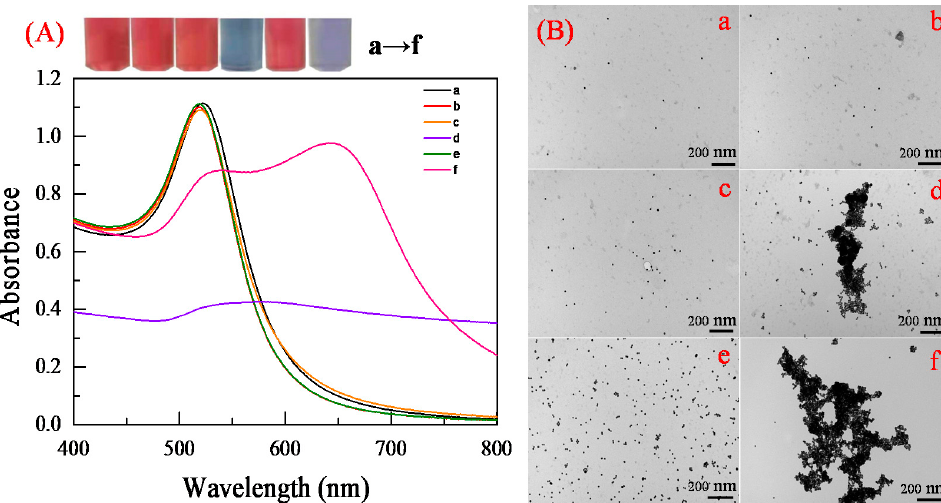
Figure 3. The UV absorption spectra and photograph ( A ) of 300 µ L Au NPs dispersed in the sensing system: as-prepared ( a ), in the presence of 0.07 µ M aptamer ( b ), in the presence of 350 nmol/mL DEX ( c ), in the presence of 36.7 mM NaCl ( d ), in the presence of 36.7 mM NaCl and 0.07 µ M DEX- aptamer ( e ), and in the presence of 36.7 mM NaCl, 0.07 µ M aptamer, and DEX at concentrations of 350 nmol/mL ( f ), shown in their respective transmission electron microscopy images ( B ).